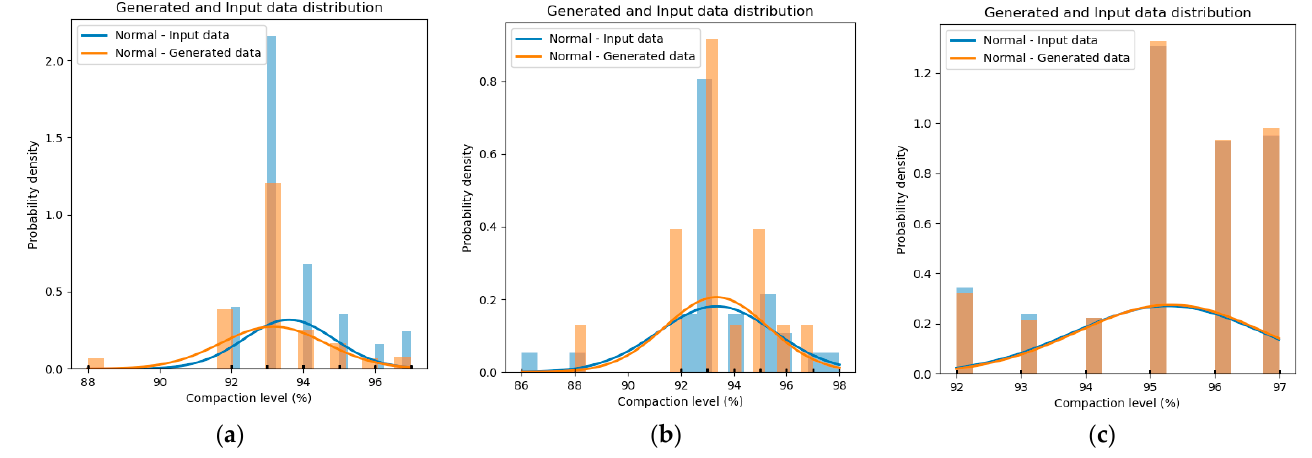
Figure 3. Comparison between the distribution of generated data and input data for the geotechnical critical variable “compaction level (%)”. ( a ) Distributions corresponding to Experiment 1. A difference can be seen between the probability density of input data versus generated data, mainly due to the small amount of data and the imbalance of the classes used for the generation. ( b ) Distributions corresponding to Experiment 2; it shows an improvement compared to ( a ) when considering balanced classes for generation. ( c ) Distributions corresponding to Experiment 3; a similarity of the probability densities between both data sets is observed due to the increase and balancing of the training samples.